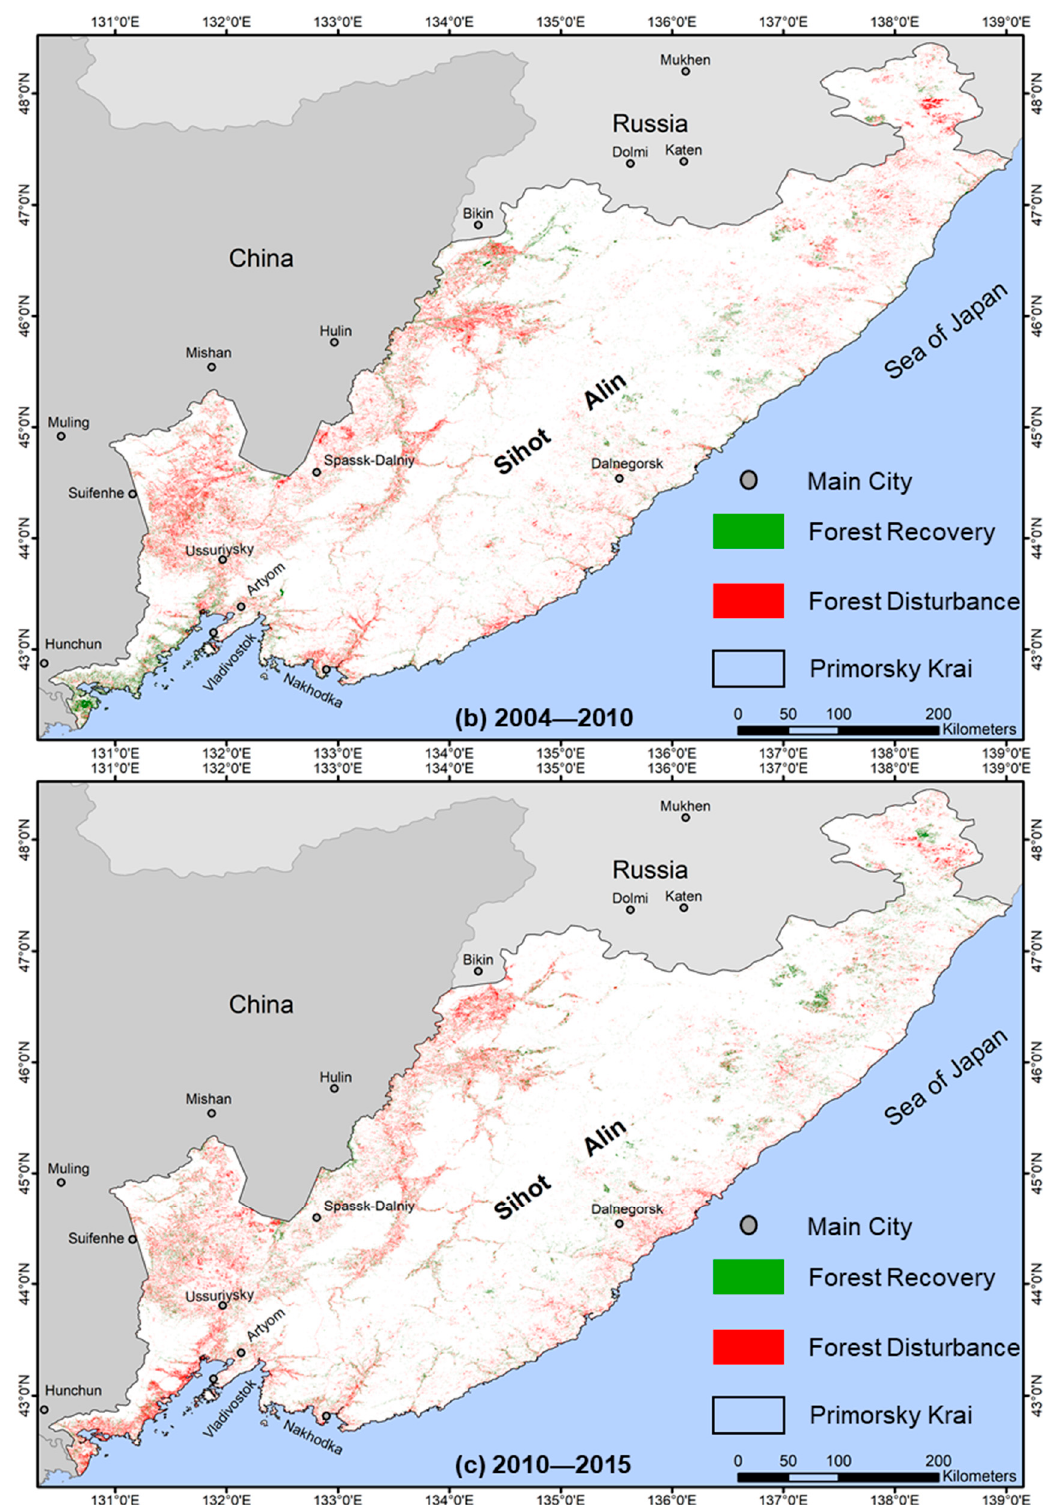
Figure 5. Forest disturbance and recovery from 1998 to 2015. ( a ) Forest change from 1998 to 2004; ( b ) forest change from 2004 to 2010; ( c ) forest change from 2010 to 2015. Forest disturbance and recovery occurred mainly in the lowlands and plains west of Sihot Alin.